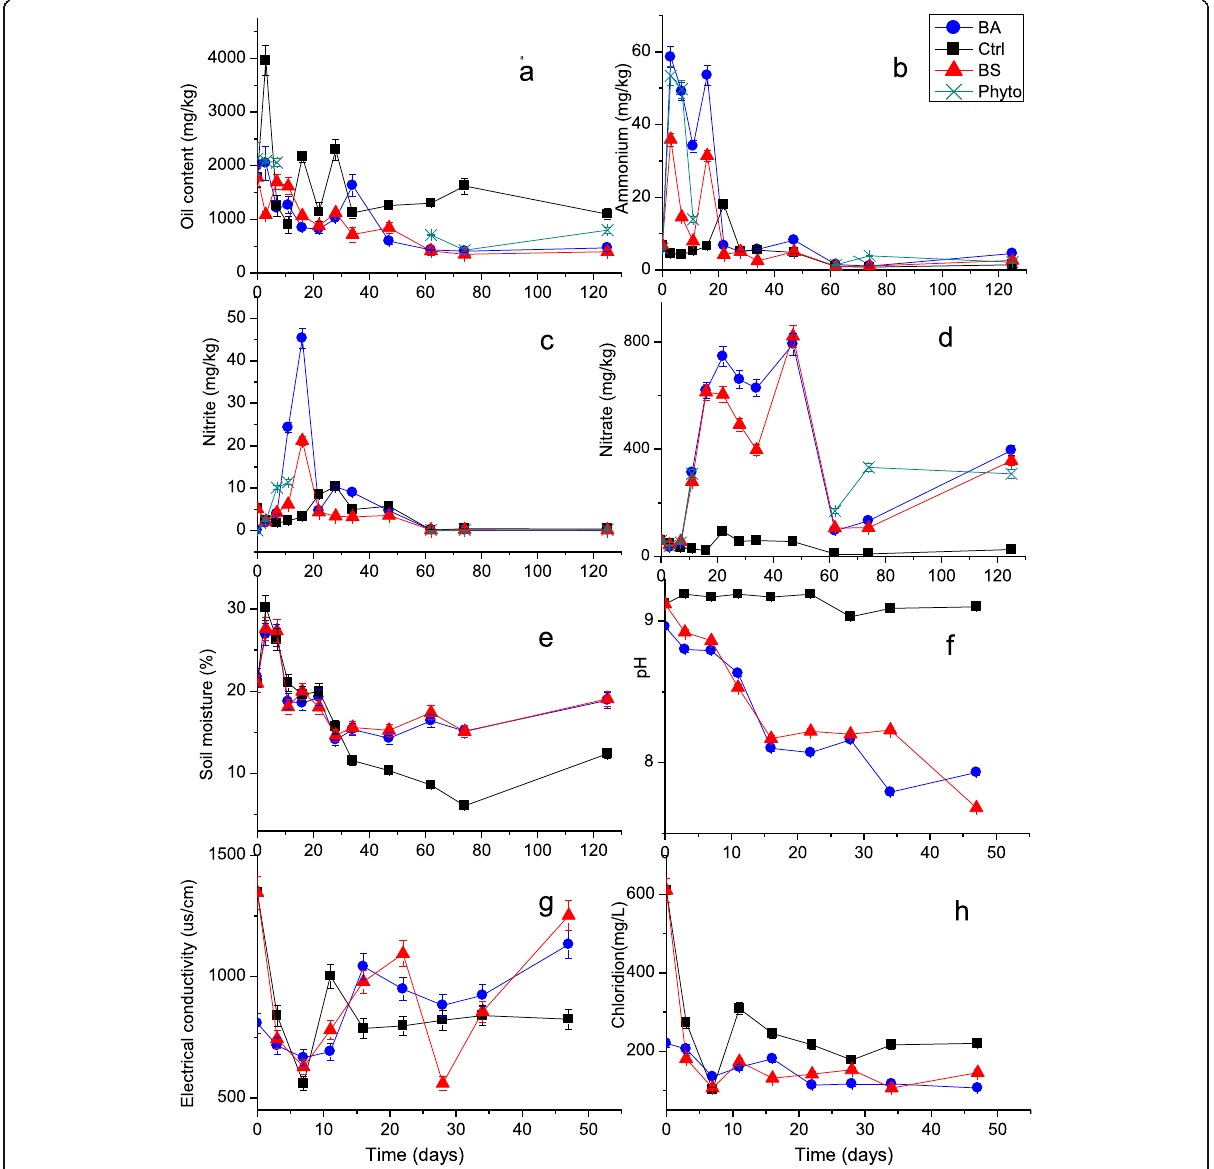
Fig. 2 Variations in a oil content, b – d nitrogen concentration, and e – h other physical and chemical parameters. A five-point sampling, coning, and quartering method was used to collect samples, thus a mixed sample was collected in each block at each time. Error bars present the standard deviation (SD) of test results ( n =